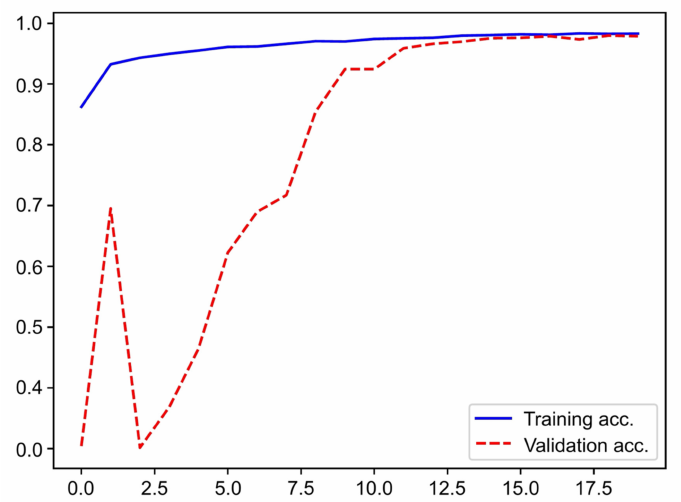
Figure 3. Evolution of the accuracy of the convolutional neural network during training and valida- tion phases, as the training and validation datasets were repeatedly input in the neural network.